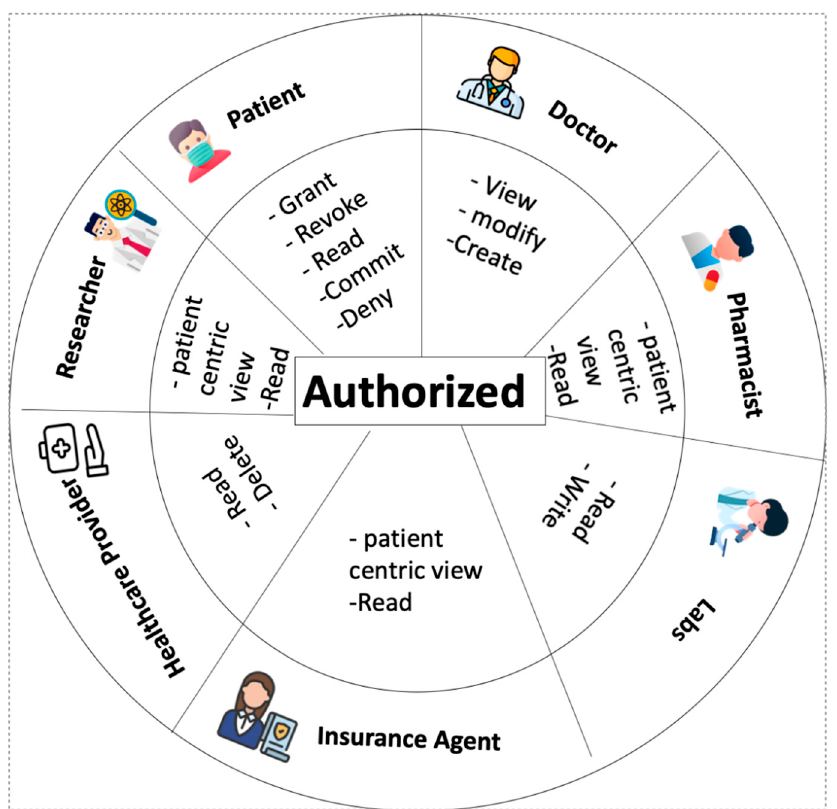
Figure 6. Stakeholders and rule-based access in PCEHRM.